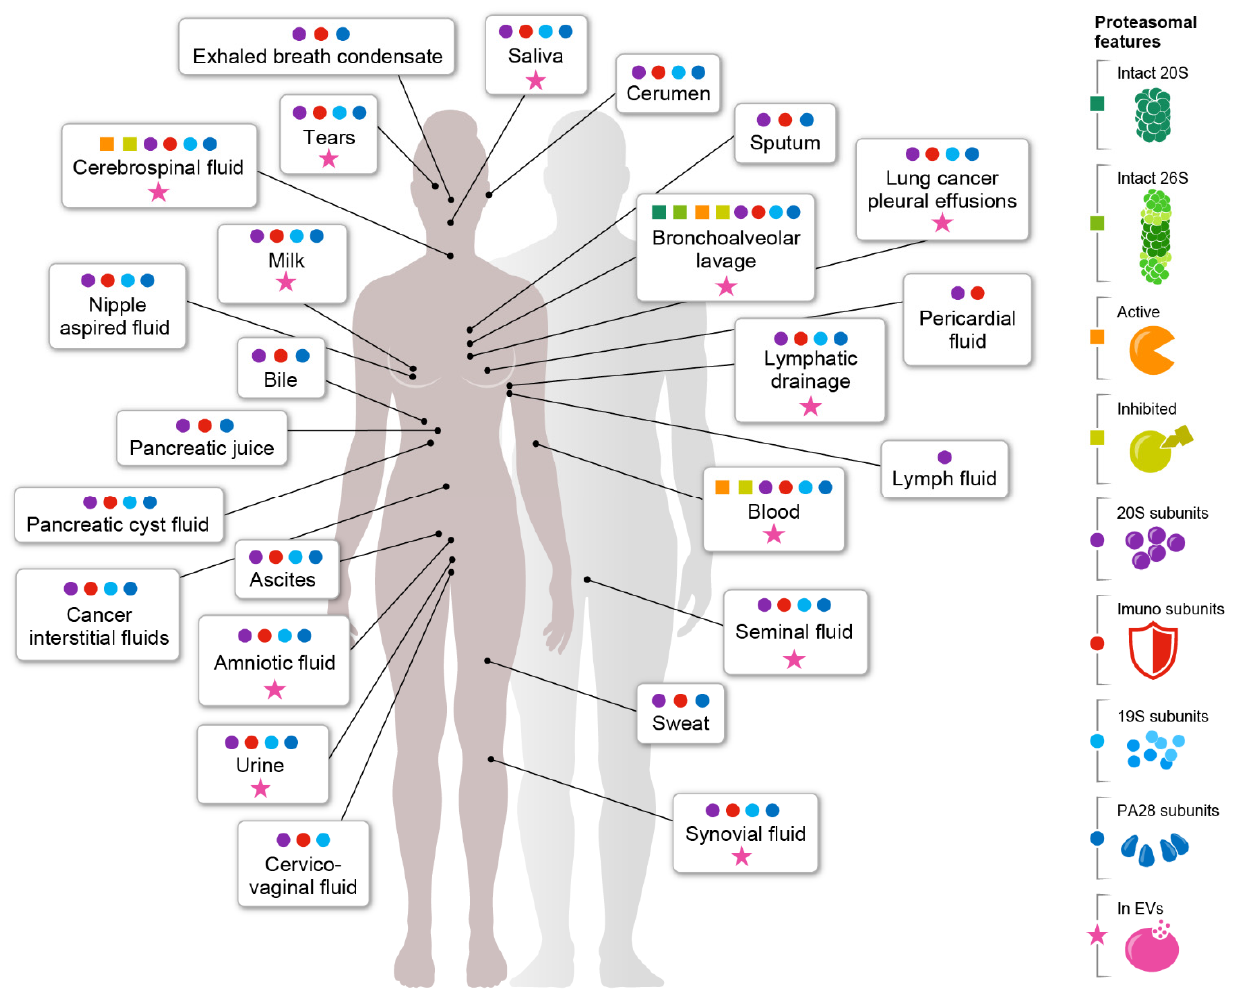
Figure 2. Proteasome subunits are found in at least 25 body fluids. Analysis of 143 proteomic datasets revealed that proteasome subunits are found in 25 different body fluids. The schematic map highlights the different body fluids, which indicate the presence of 20S proteasome subunits (purple circles), immunoproteasome subunits (red circles) and subunits of the 19S (light blue circles) and PSA28 αβ activators (dark blue circles). In addition, the scheme indicates whether intact 20S (dark green squares) or intact 26S proteasomes (light green squares) were found, whether the activity of the proteasomes was determined (orange squares) and if it was inhibited by proteasome inhibitors (lime green squares). Pink asterisks indicate body fluids in which proteasome subunits were found within extracellular vesicles.